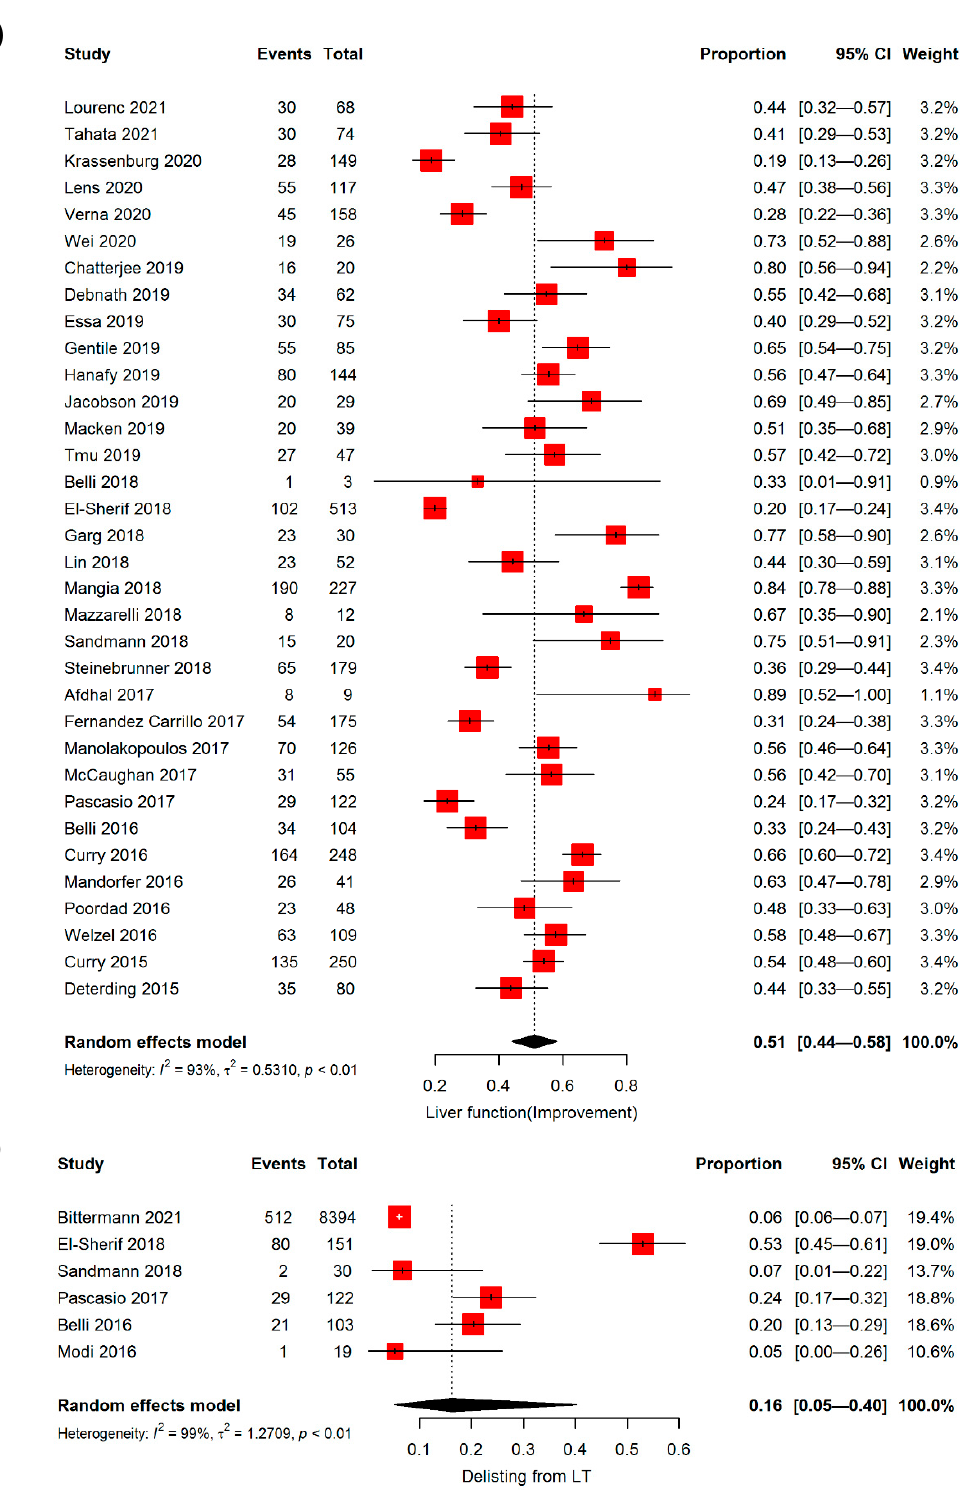
Figure 3. Estimated event rate of ( A ) improvement in liver function, ( B ) delisting from liver trans- plantation, and ( C ) worsening in liver function of decompensated liver cirrhosis patients treated with direct-acting antiviral (DAA). 3.5. Efficacy and Safety of PI-based DAA in DC Patients Since the efficacy of PI-based DAA has not been fully studied in DC patients, its safety was compared to that of non-PI-based DAAs. The PIs included in this study were glecaprevir, grazoprevir, paritaprevir, and simeprevir. The pooled SVR for 6315 PI-based DAA-treated DC patients was 85% (95% CI: 0.75 – 0.91), which did not differ from the non-PI-based treated group (n = 7866), with an SVR of 86% (95% CI: 0.84 – 0.89) (Table 2). In addition, PI did not have a significant impact on either AEs or SAEs, with pooled rates of 49% vs. 58% and 23% vs. 18% in PI- and non-PI-based treatments, respectively (Table 4). Patients treated with a PI-containing regimen (n = 2244) were more likely to be associated with the deterioration of liver function with a pooled event rate of 22% (95% CI: 0.20 – 0.25), while non-PI-based regimens (n = 2661) showed a pooled event rate of 14% (95% CI: 0.09 – 0.2). In contrast, the improvement in liver function was comparable between these two groups: 49% vs. 51% (n = 204, 95% CI: 0 – 1 and n =